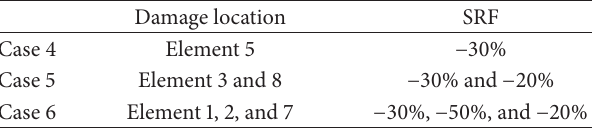
Table 3: Damaged Cases 4, 5, and 6.